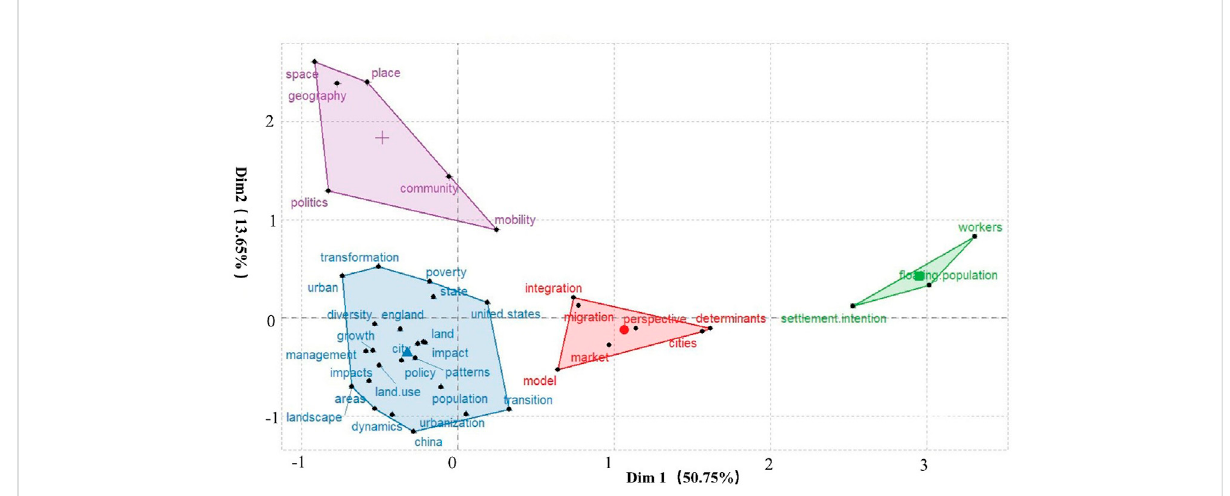
Multiple correspondence analysis of high -frequency keywords in rural settlements fi